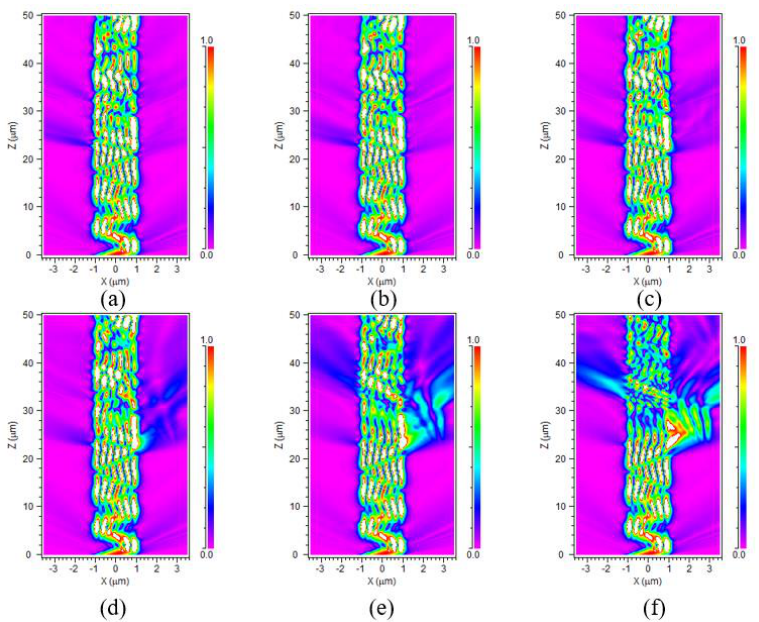
Figure 7. The light distribution of the OW when ( a ) n = 1.33, ( b ) n = 1.43, ( c ) n = 1.53, ( d ) n = 1.63, ( e ) n = 1.73, and ( f ) n = 1.83. n is the refractive index of the detected material.